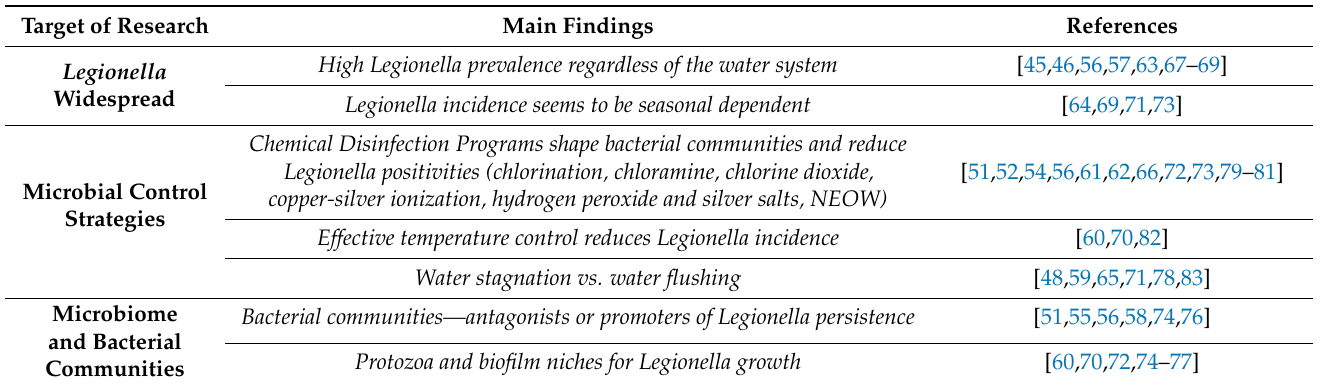
Table 1. Overview of recent Legionella field-based studies and their main findings. Target of Research Main